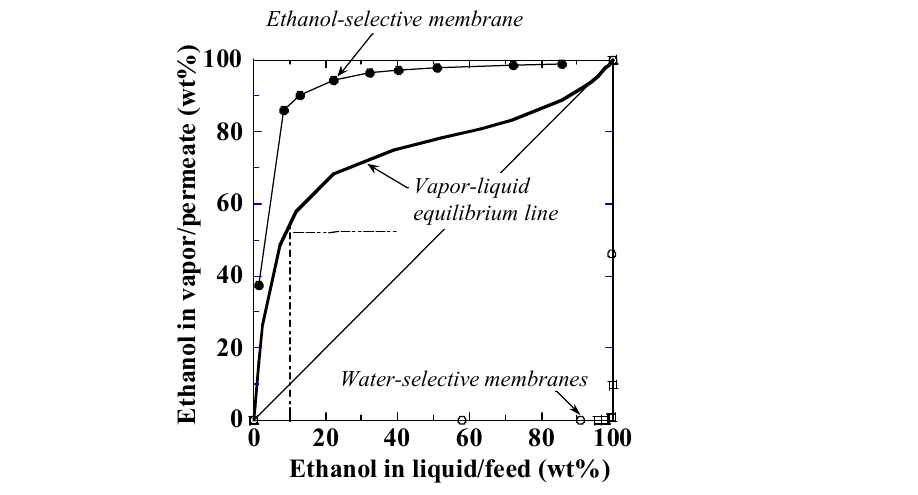
Figure 5. Liquid-vapor equilibrium of ethanol-water mixture with example separation performances of water- and ethanol-selective membranes: solid line, liquid-gas equilibrium; dashed lines, examples of stages in the distillation column; ● , ethanol concentration in the permeate of an ethanol-selective silicalite membrane [55], □ ; ○ , ethanol concentration in the permeate of water- selective A-type zeolite membranes ( □ , [54]; ○ , this study).